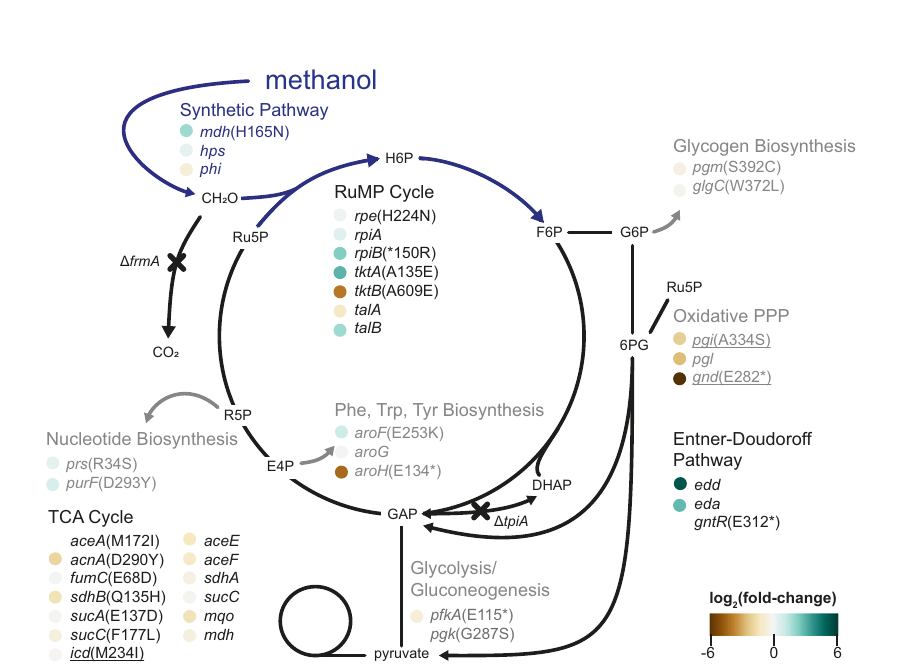
Fig. 5 | Genetic and proteome changes of methylotrophic E. coli strains. Mutations in core metabolism present in the methylotrophic population after 249 generations of chemostat evolution are shown. Additional genetic changes found